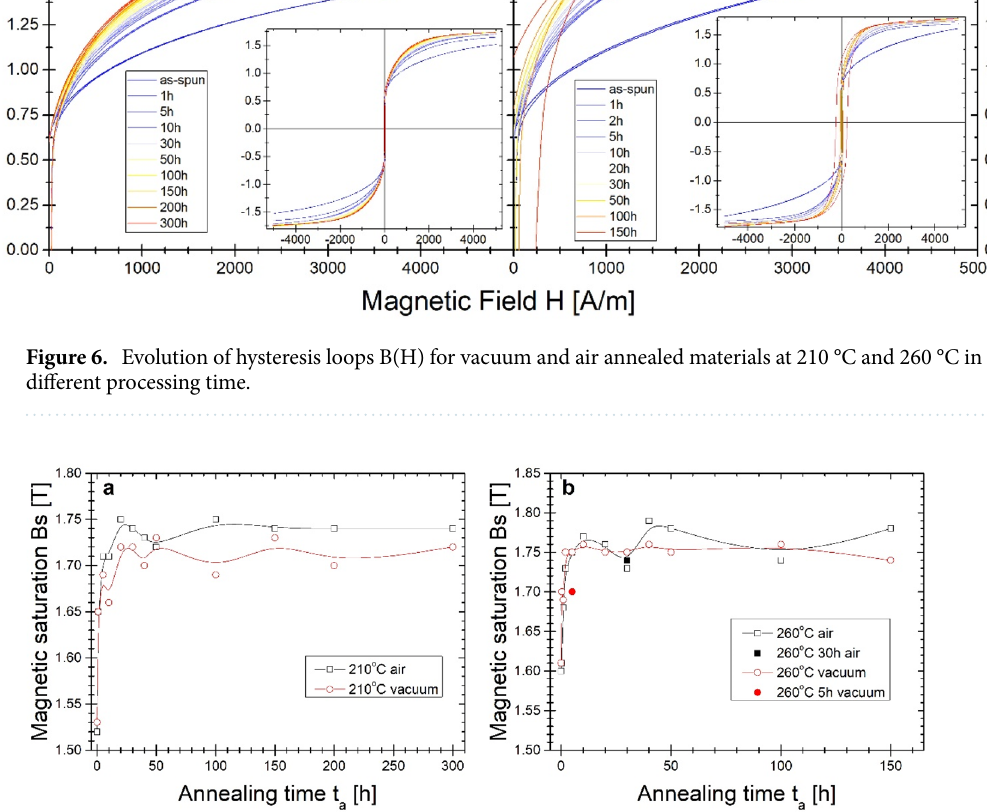
Figure 7. Magnetic saturation on the annealing time of the isothermal process at ( a ) 210 °C and ( b ) 260